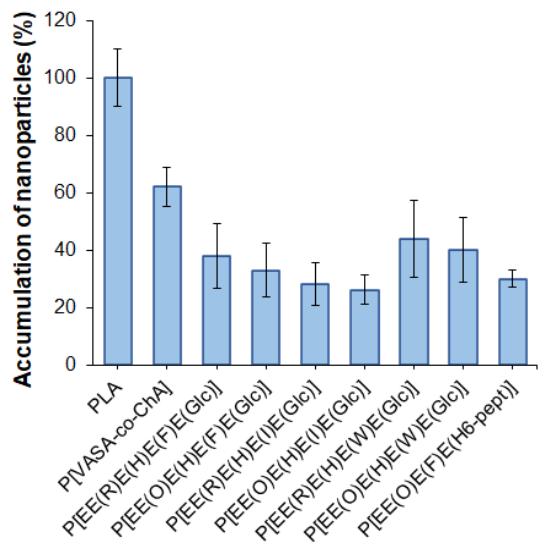
Figure 8. Accumulation of nanoparticles by macrophages after 5 h of co ‐ incubation.